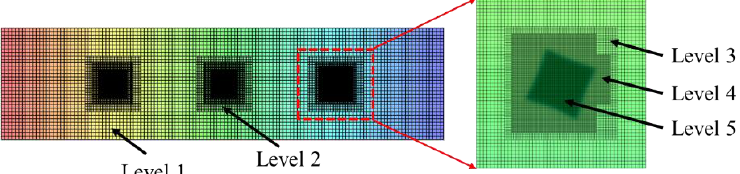
Figure 5. Schematic for the mesh created for computing domain by using the adaptive mesh refinement (AMR) technique.